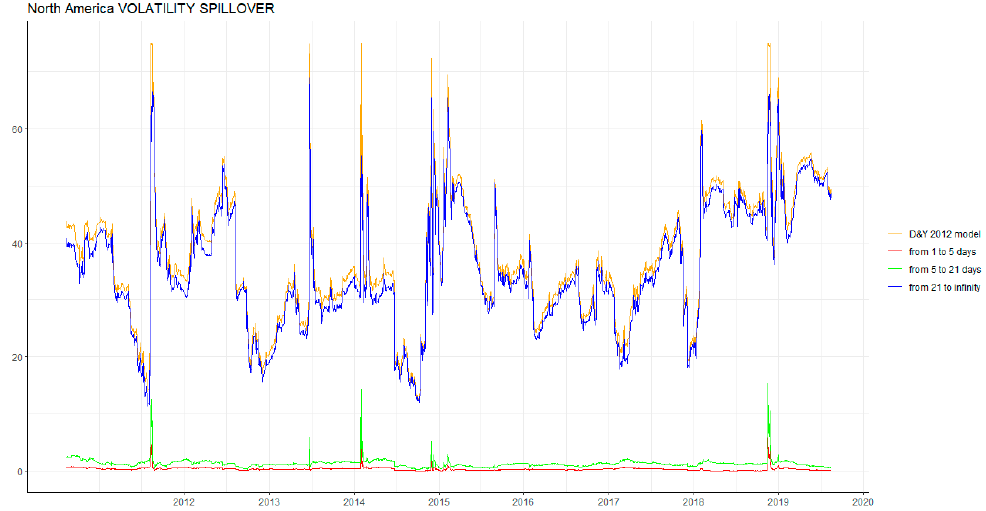
Energies 2020 , 13 , x FOR PEER REVIEW Figure A8. Total return spillover of DY12 and BK18 in Europe (Windows 370). Figure A8. Total return spillover of DY12 and BK18 in Europe (Windows 370).